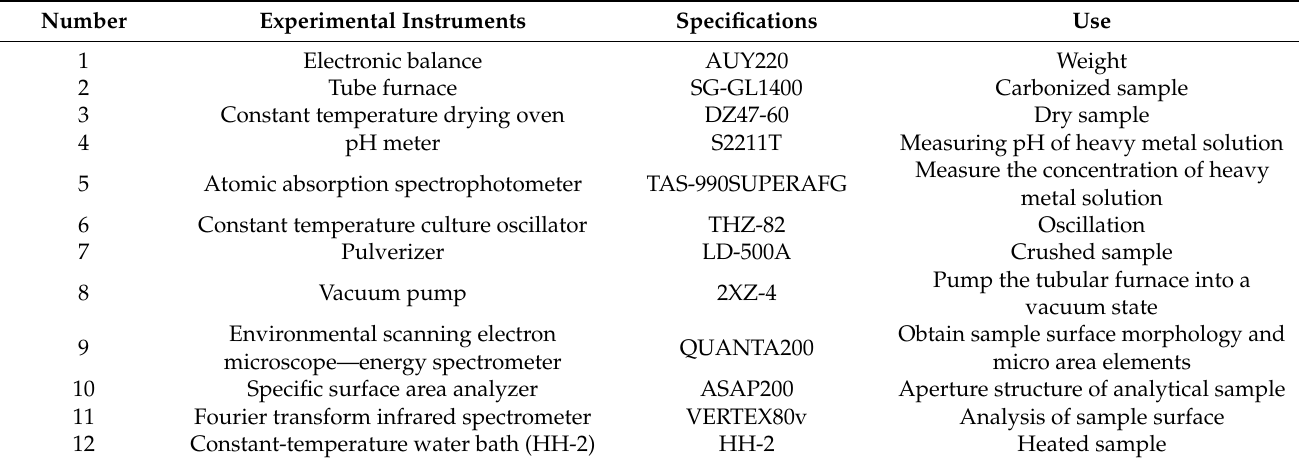
Table 2. Experimental